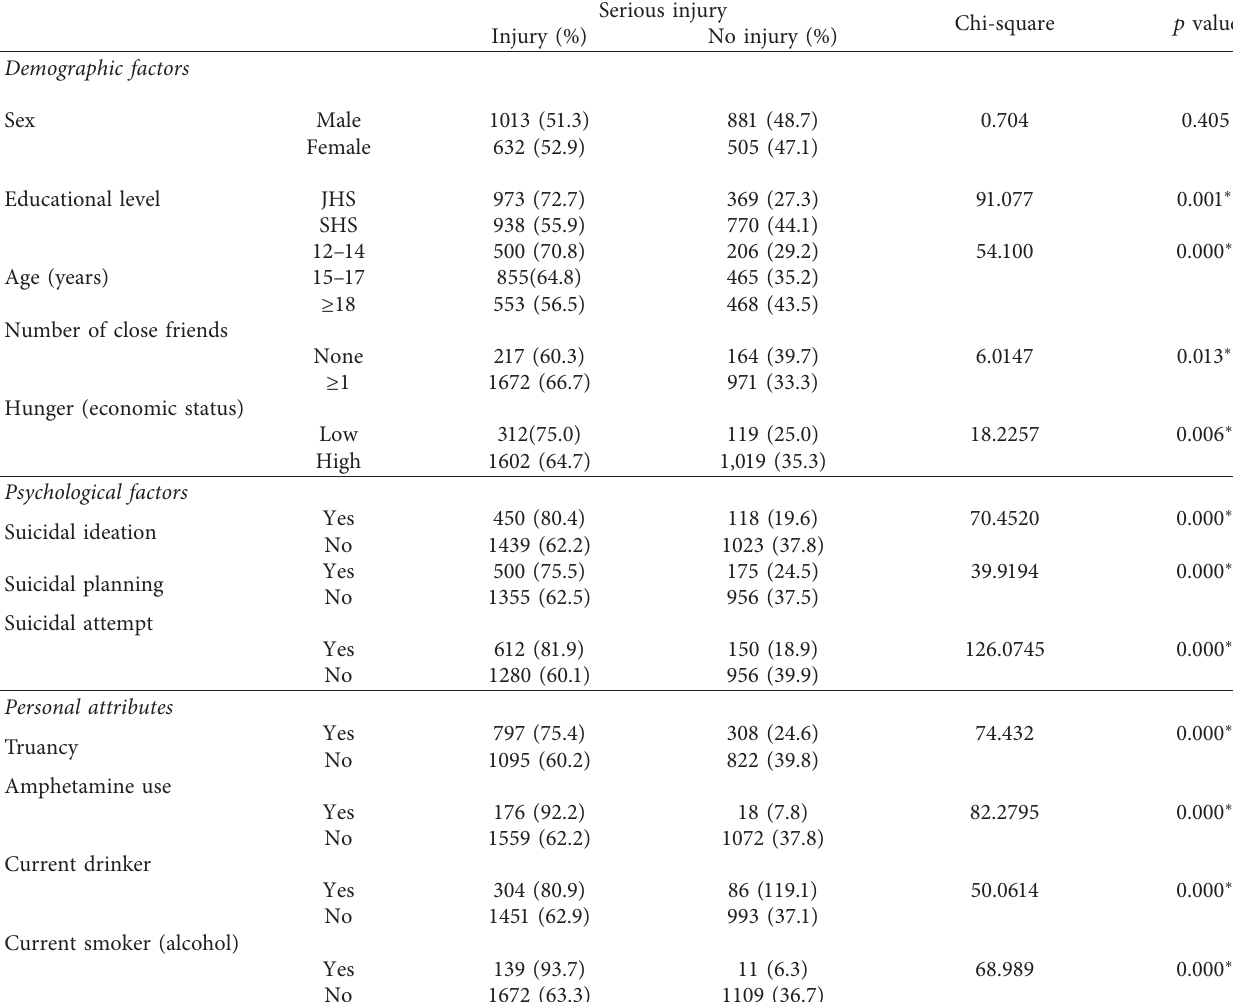
Table 3: Distribution of serious injuries across demographic, psychological, and personal attribute factors.